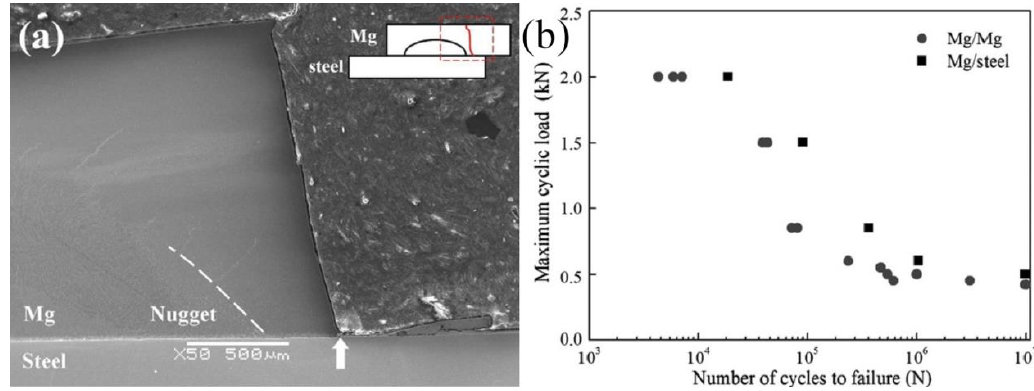
Figure 26. Mg/steel RSW [94] ( a ) fatigue fractures at a maximum load of 2.0 kN; ( b ) fatigue properties.